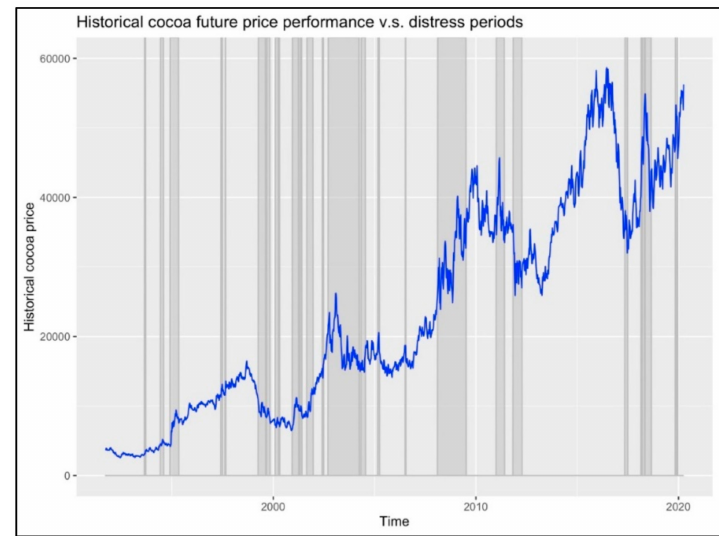
Figure 1. The historical one-month cocoa future price and the distress regime period estimated with a two-regime, Gaussian time-fixed standard deviation MS